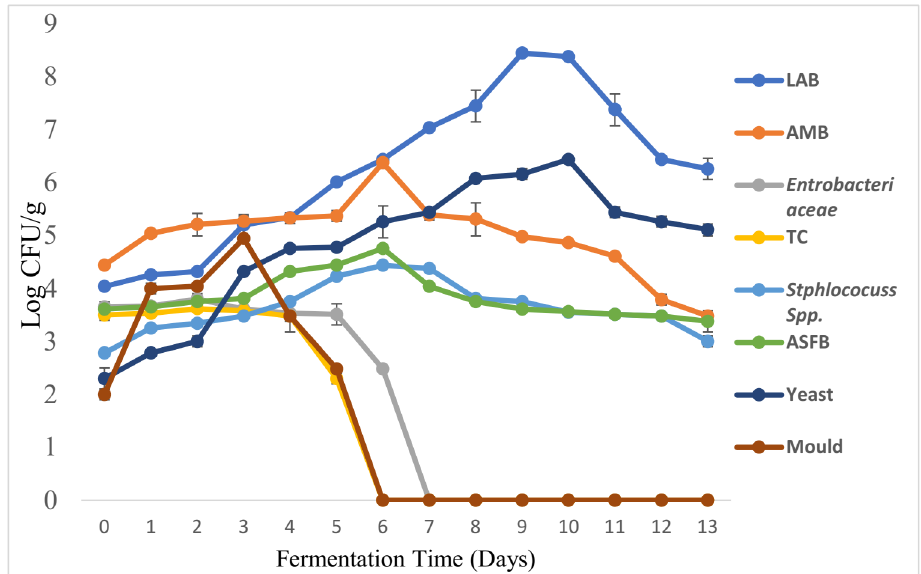
Figure 6. Growth dynamics of various microbial groups during the fermentation of maize-based Shameta; LAB = lactic acid bacteria, AMB = aerobic mesophilic bacteria, TC = total coliforms, ASFB = aerobic spore forming